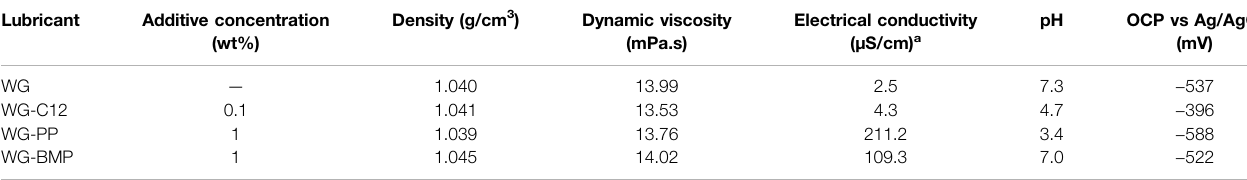
TABLE 5 | Wear track chemical composition after XPS analysis. Sample